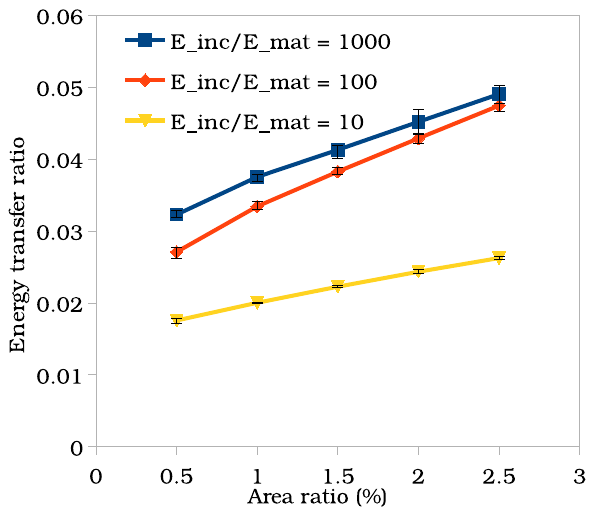
Figure 12. The energy conversion rate calculated by (Equation (14)) vs. the inclusion area ratio. Several setups are created for each configuration; hereafter, the averaged results are plotted. The error bar represents the upper and lower boundary of the calculation